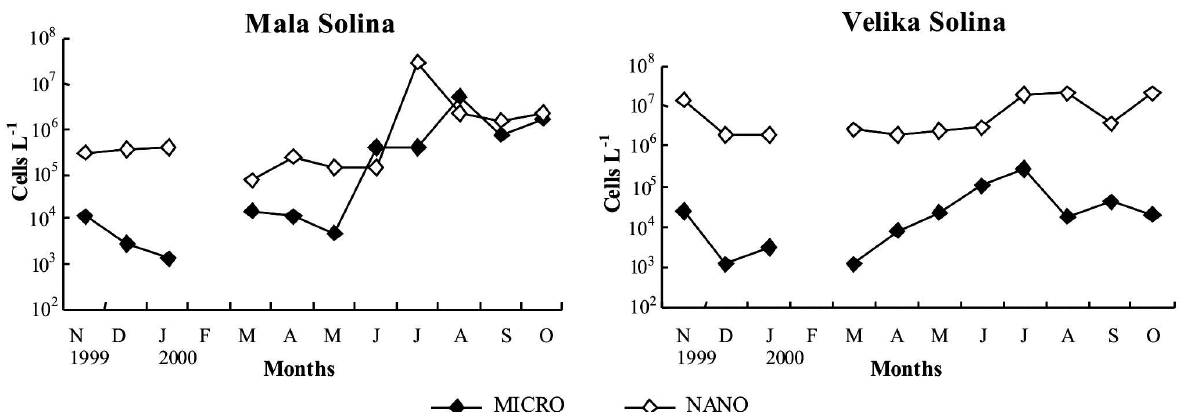
Fig . 5. – Monthly distribution of microphytoplakton (MICRO) and nanophytoplankton (NANO) abundances in Mala Solina and Velika Solina.